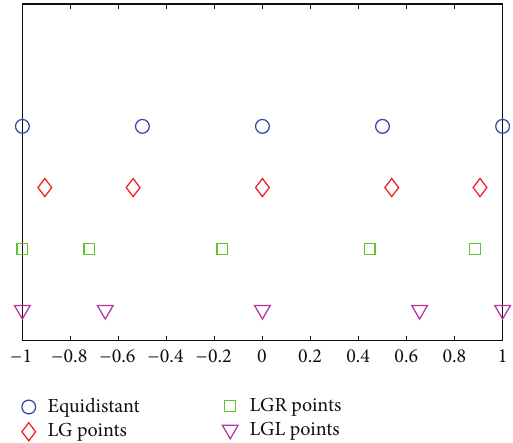
Figure 6: Legendre-Gauss (LG), Legendre-Gauss-Radau (LGR), and Legendre-Gauss-Lobatto (LGL) with five points. Table 2: Position of equidistant, LG, LGR, and LGL with five points within [−1,1]